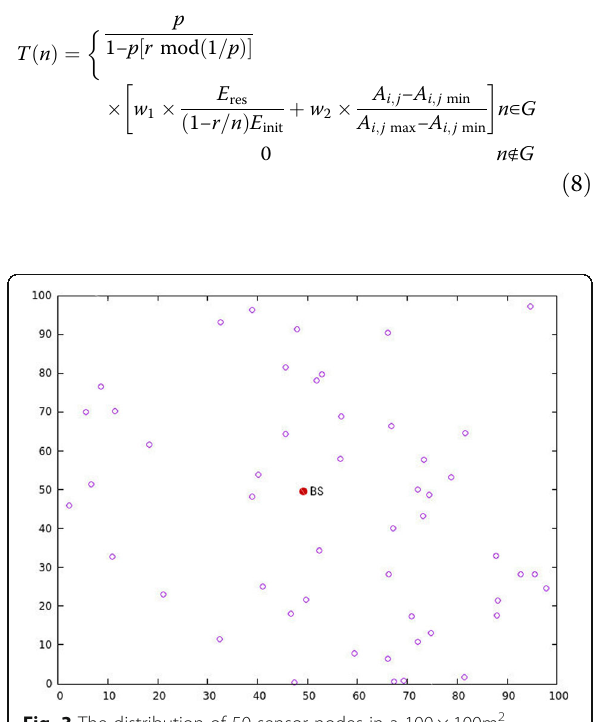
Fig. 3 The distribution of 50 sensor nodes in a 100 × 100m 2 network topology